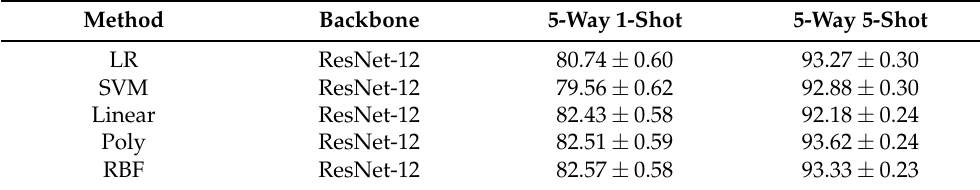
Table 9. Comparison results of different methods in the WHU-RS19